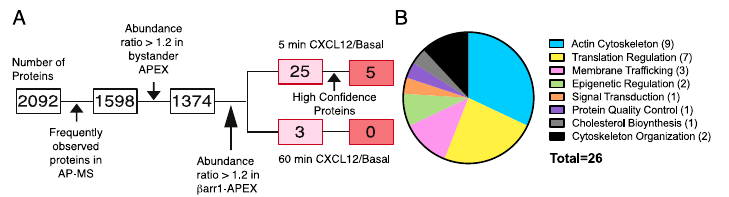
Figure 4. Filtering approach and protein classification of β -arrestin1-interacting proteins. ( A ). Schematic of the filtering approach to select high confidence β arr1-interacting proteins. Number of proteins identified by mass spectrometry totaled approximately 2092 proteins. Proteins frequently observed in affinity purification mass spectrometry (AP-MS) experiments according to the CRAPome database (https://reprint-apms.org/) accessed on 7 January 2022 were removed, reducing the list to ~1598 proteins. Proteins were also removed if they had an abundance ratio >1.2 in any of the bystander APEX conditions, reducing the list to ~1374 proteins. The list of these proteins is